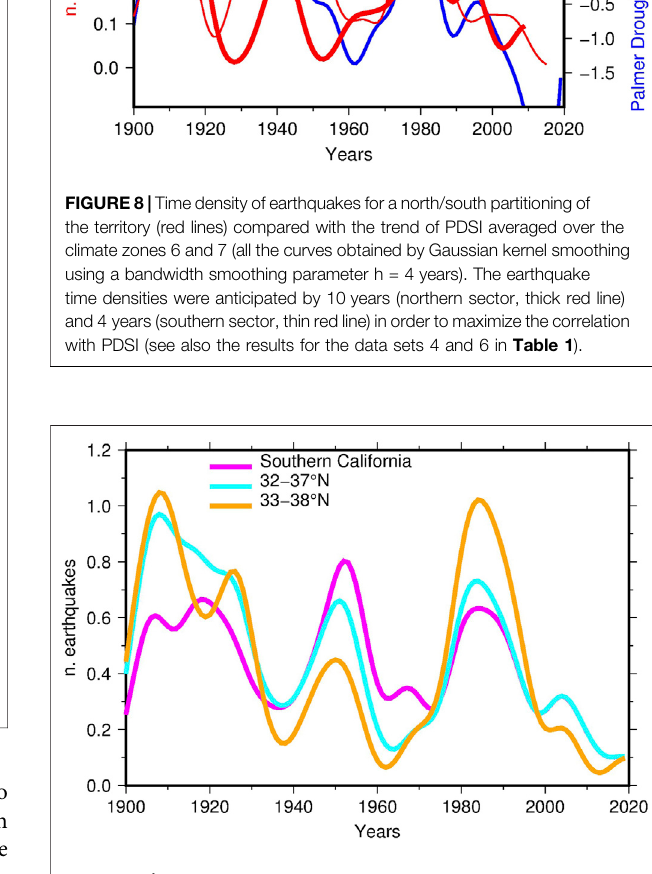
FIGURE 9 | Smoothed time densities of earthquakes obtained for the original data set (magenta) and moving the study area to the north by one degree of latitude (cyan) and two degrees of latitude